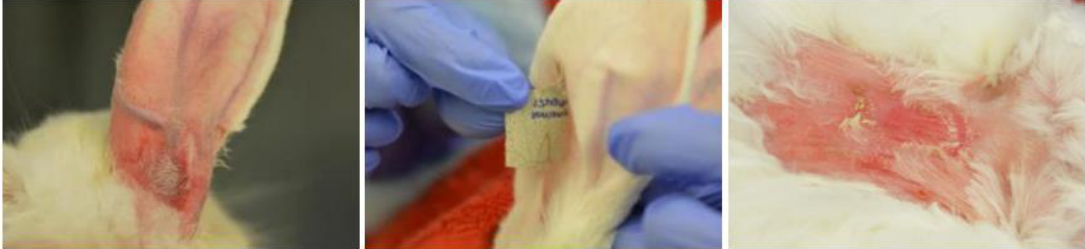
Figure 6. Representative images of skin condition after patch removal (left: group 1, middle: group 2 and right: group 3).